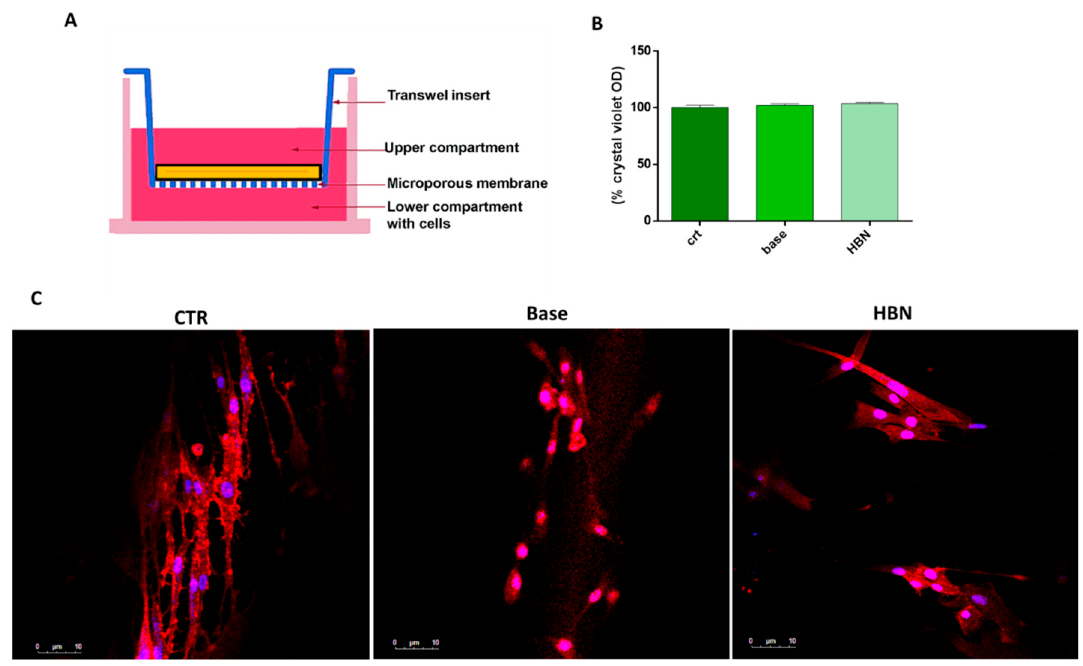
Figure 8. Transwell inserts ( A ) and the % crystal violet OD, directly proportional to cell viability of control cells and cells exposed to HBN formulation in comparison with those exposed to the base formulation ( B ). ( C ) Human derived fibroblast (HDF) cell morphology for the control cells, base formulation and hyaluronic acid (HA)-based formulation after 24 h. In red are Actin filaments stained by AttoRho6G–phalloidin, and in blue are DAPI-stained nuclei cells. Bars represent 10 μ m.